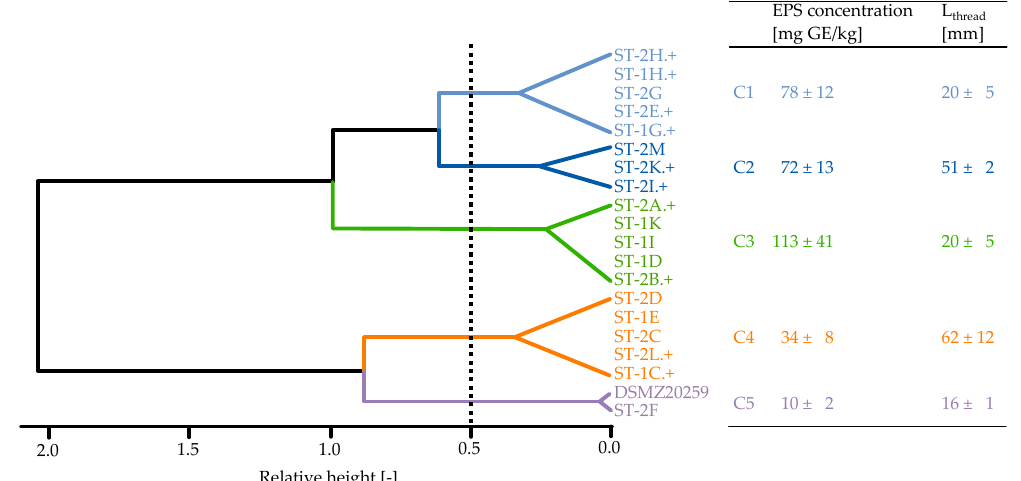
Figure 2. Cluster plot of Euclidian distance cluster analysis using Ward linkage on length of thread (L thread ) and EPS concentration of acid gel suspensions. Inserted table represents average data of L thread and EPS concentration for each cluster (C). A ‘+’ after the strain code indicates microscopic evidence of cell-bound EPS.